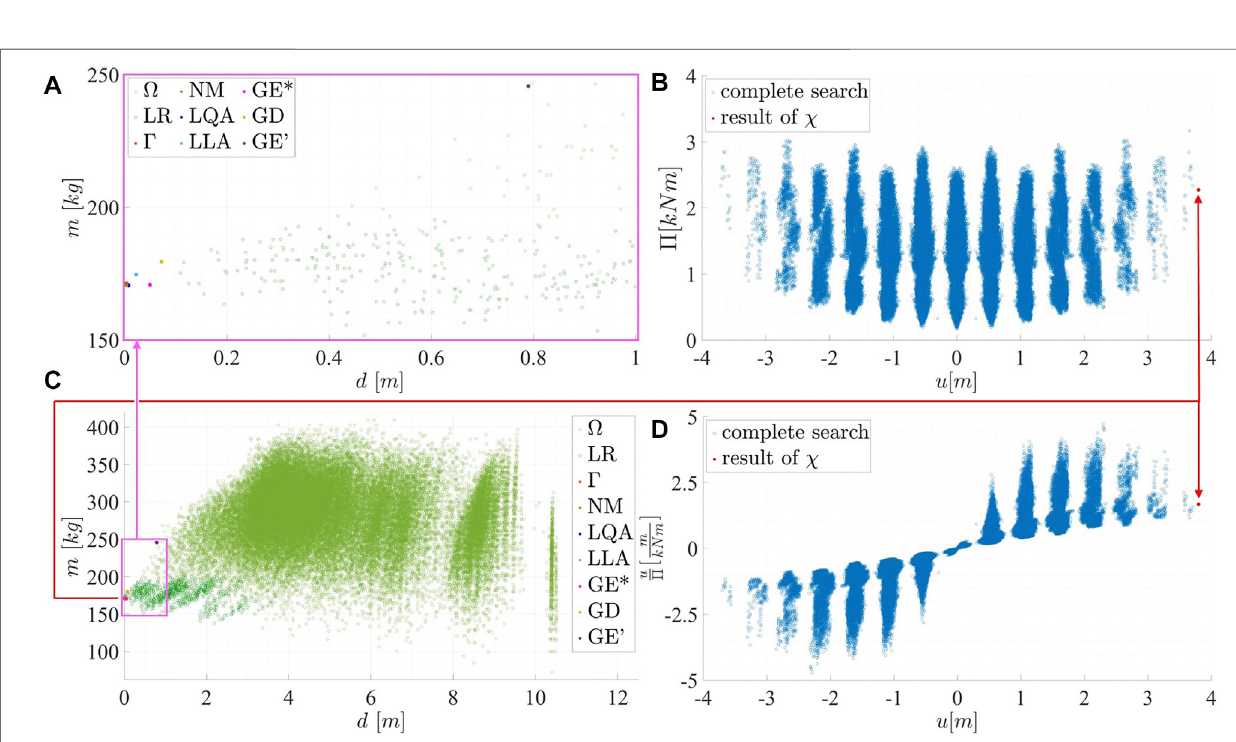
Frontiers in Built Environment |